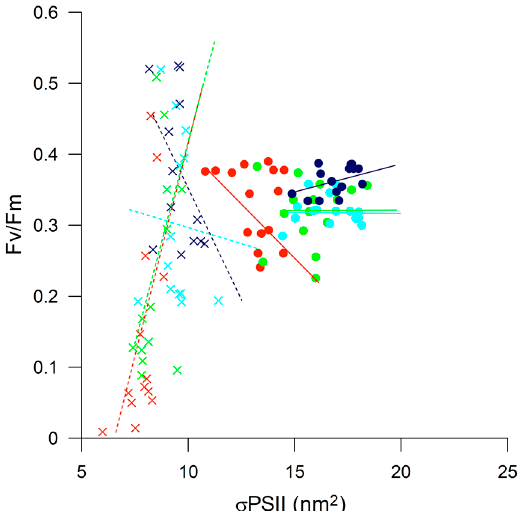
Figure 8. Fv/Fm plotted against relative functional absorption cross-section of PSII ( σ PSII) for Prorocentrum sp. (symbol X) and Phaeocystis antarctica (symbol ● ) with color indicating different levels of irradiance. Red (HL), light green (L1), light blue (L2), and blue (L3). The figure includes all data points with trend lines.